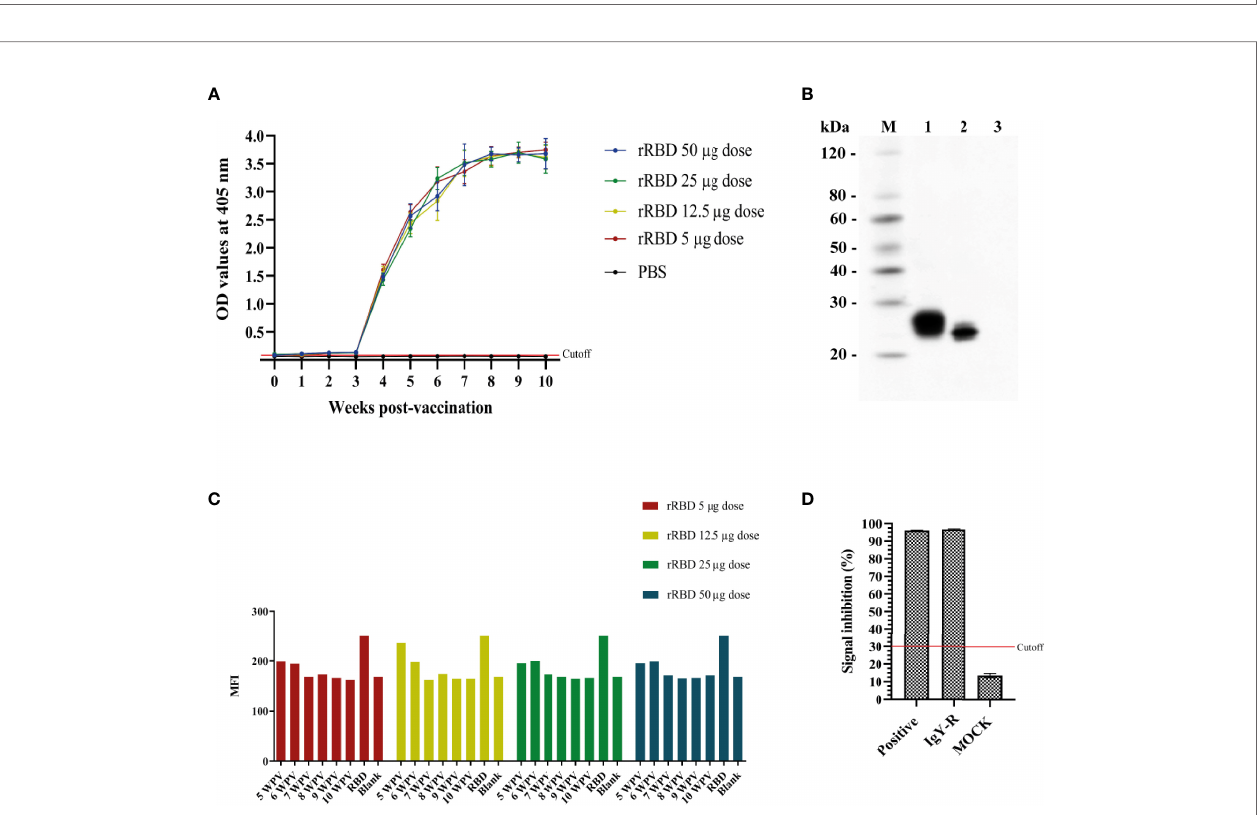
FIGURE 2 | In vitro immunoreactivity of IgY-R. (A) IgY-R raising pattern according to ELISA against the SARS-CoV-2 rRBD antigen both in serum and egg yolks of immunized hens. (B) Western Blot using IgY-R as primary antibody. Lane M: Ladder; lane 1: reduced RBD; lane 2: non reduced RBD; lane 3: PBS as control. (C) IgY-R ability to block RBD binding to Vero E6 cells. Results are presented as the mean fl uorescence intensity (MFI) given by the fl ow cytometer (D) Neutralization percent of IgY-R using the cPass SARS-CoV-2 Neutralization Antibody Detection Kit. Cutoff value is settled as 30% following manufacturer guidelines. Mean ± SD are presented.